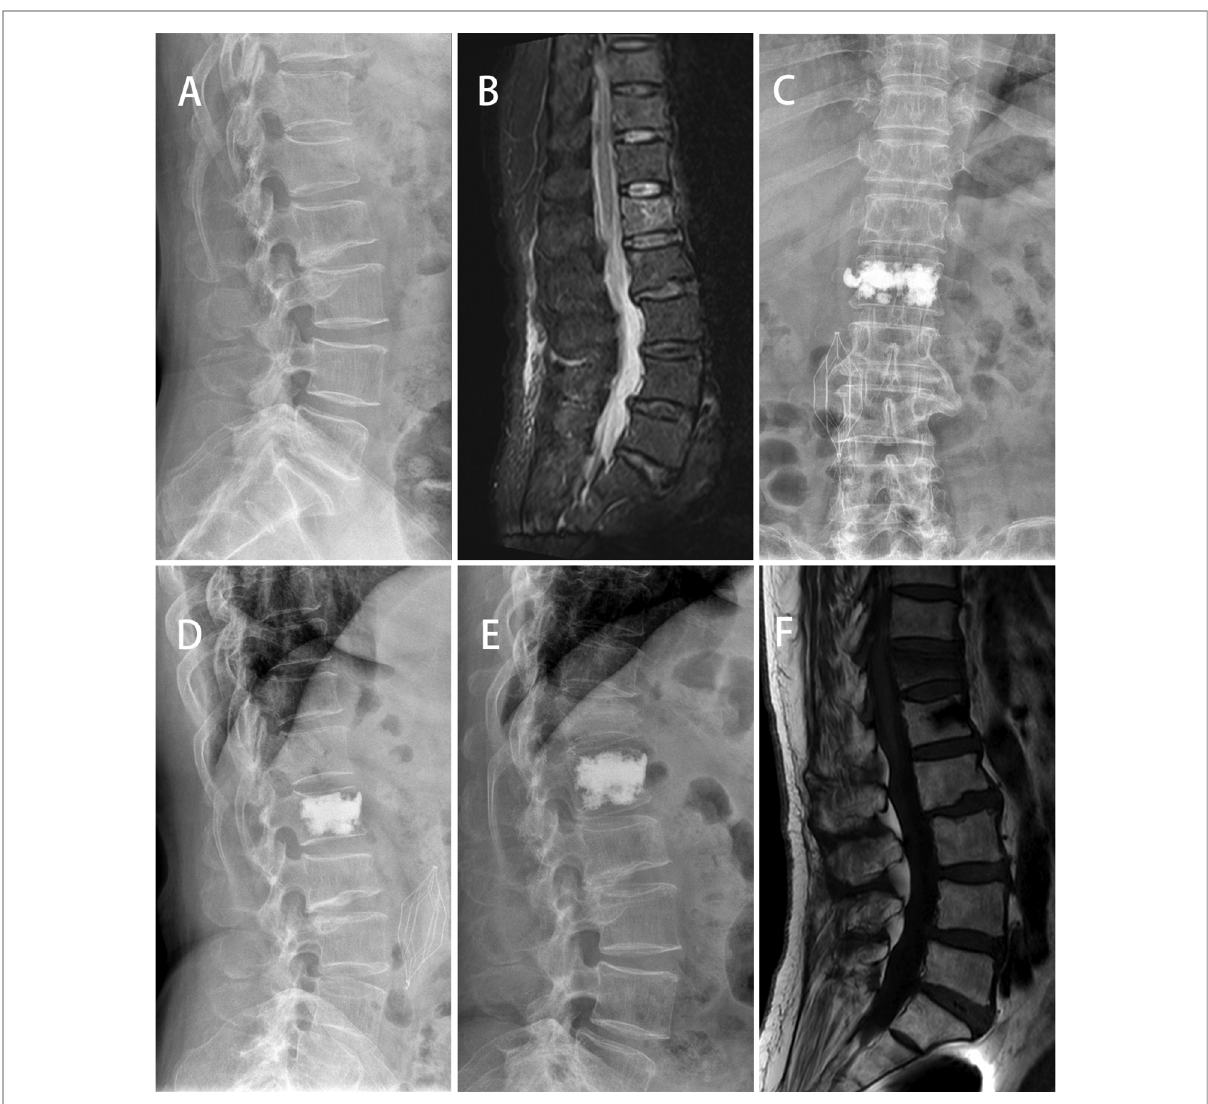
FIGURE 3 A 64-year-old female patient with L1 vertebral compression fractures developed adjacent vertebral compression. X -ray showed and MR showed a fresh compression fracture of L1( A,B ). After PKP surgery, x -ray showed that the bone cement on one side of the vertebra was densely distributed ( C,D ). At 12 months after surgery, the patient developed T12 OVCF ( E,F